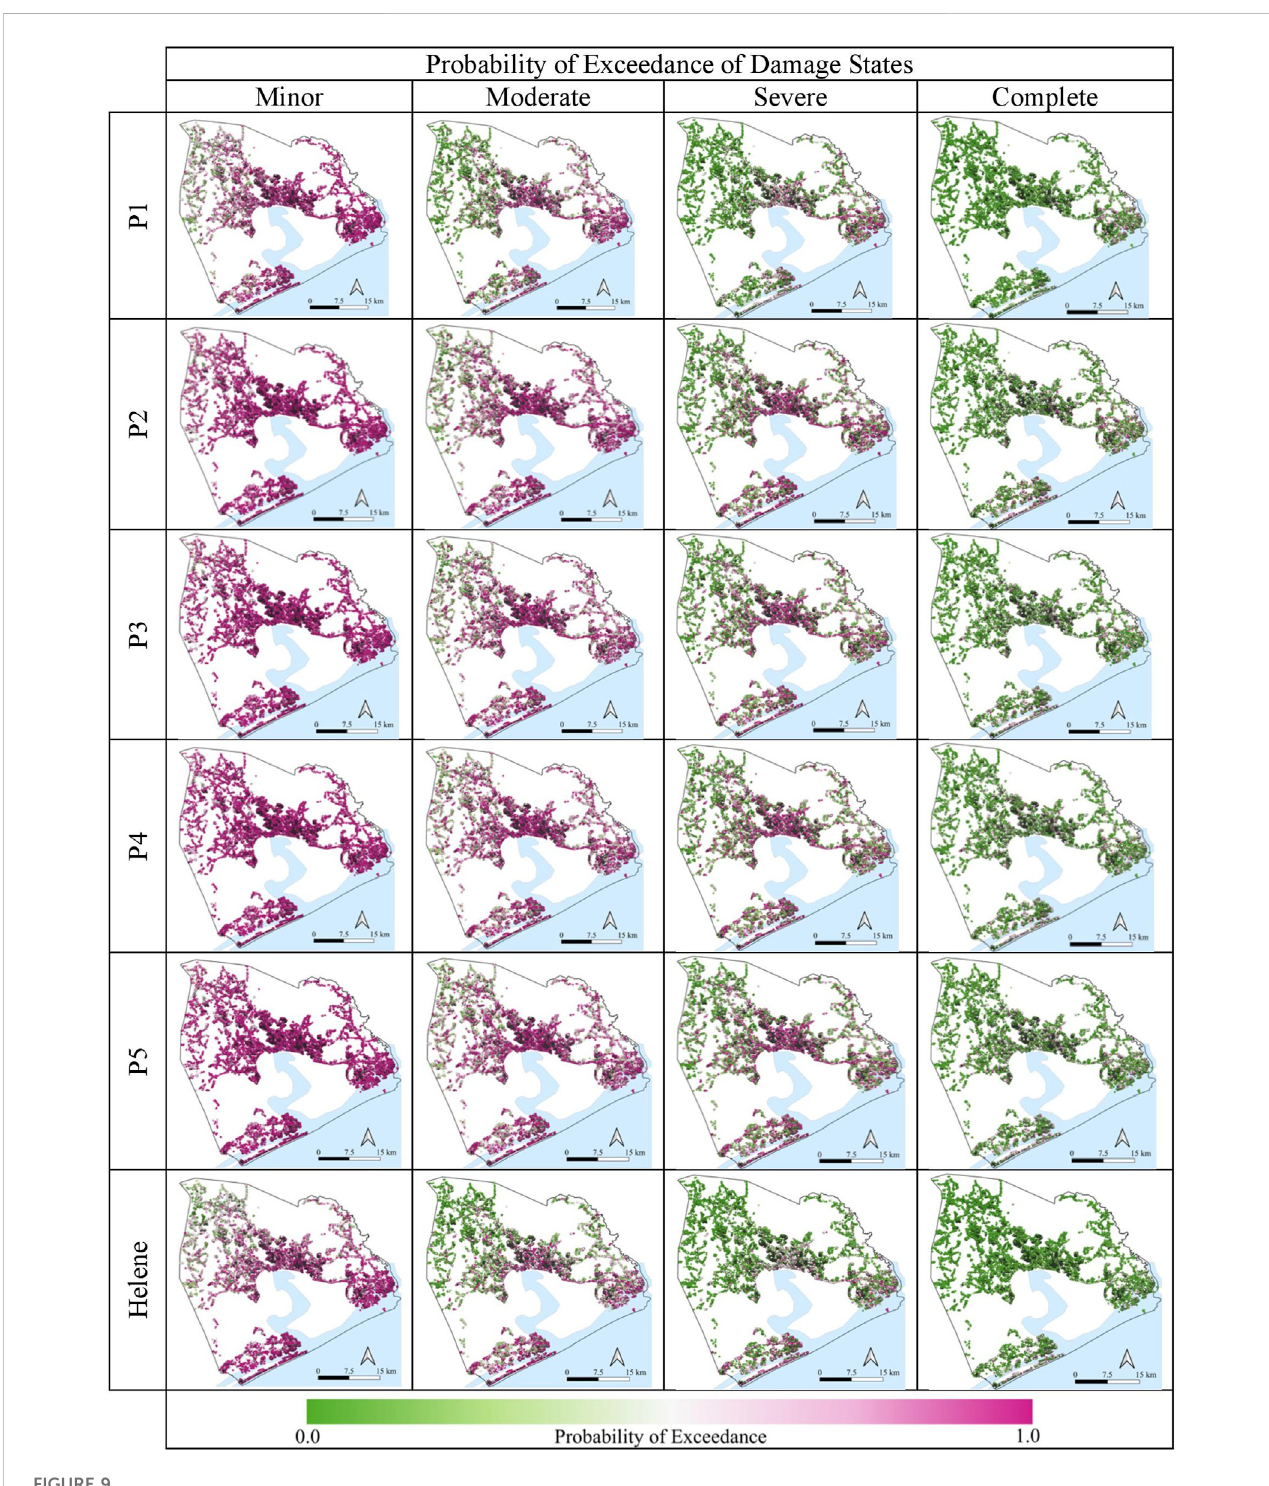
FIGURE 9 Building damage state probability maps for four damage states and six hurricane scenarios in Onslow